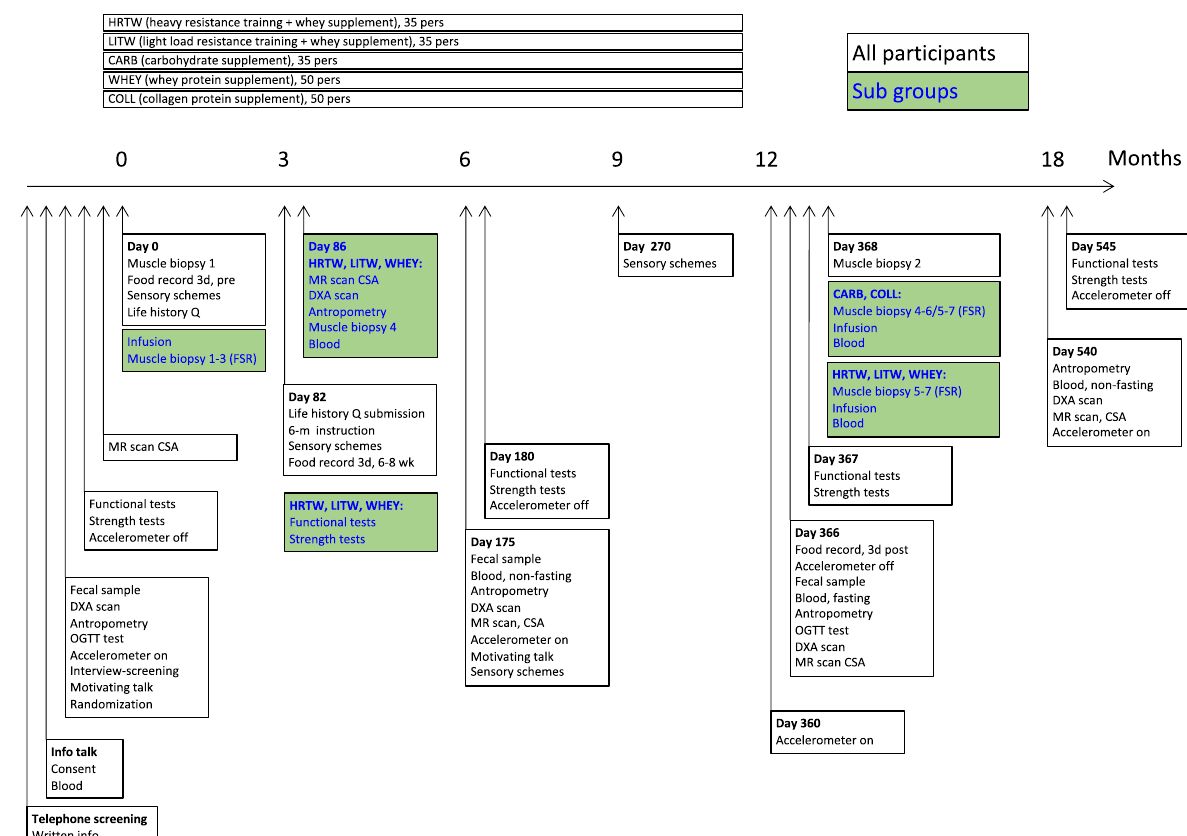
Fig. 1 Overview of the trial design incl. sub-groups. Overview of the involvement of participants in the